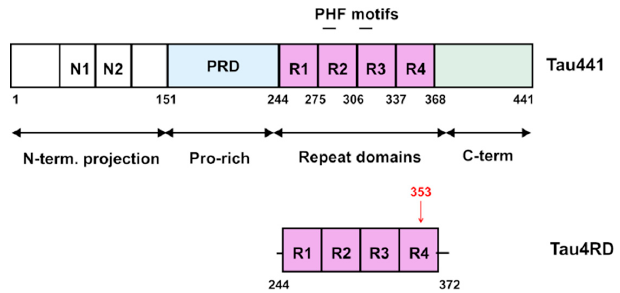
Figure 1. Schematic representation of Tau441 and Tau4RD proteins with their domain organization. The position of residue 353, that is, the conjugation site with di-ubiquitin molecules used in this work, is highlighted in